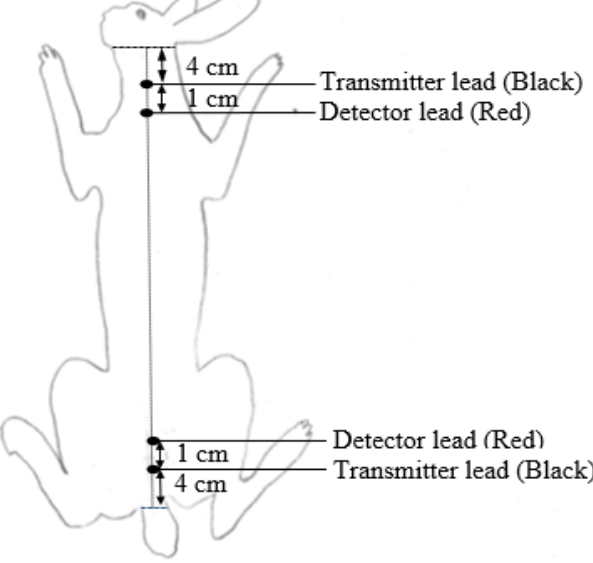
Figure 1. Electrode locations in live rabbit body.